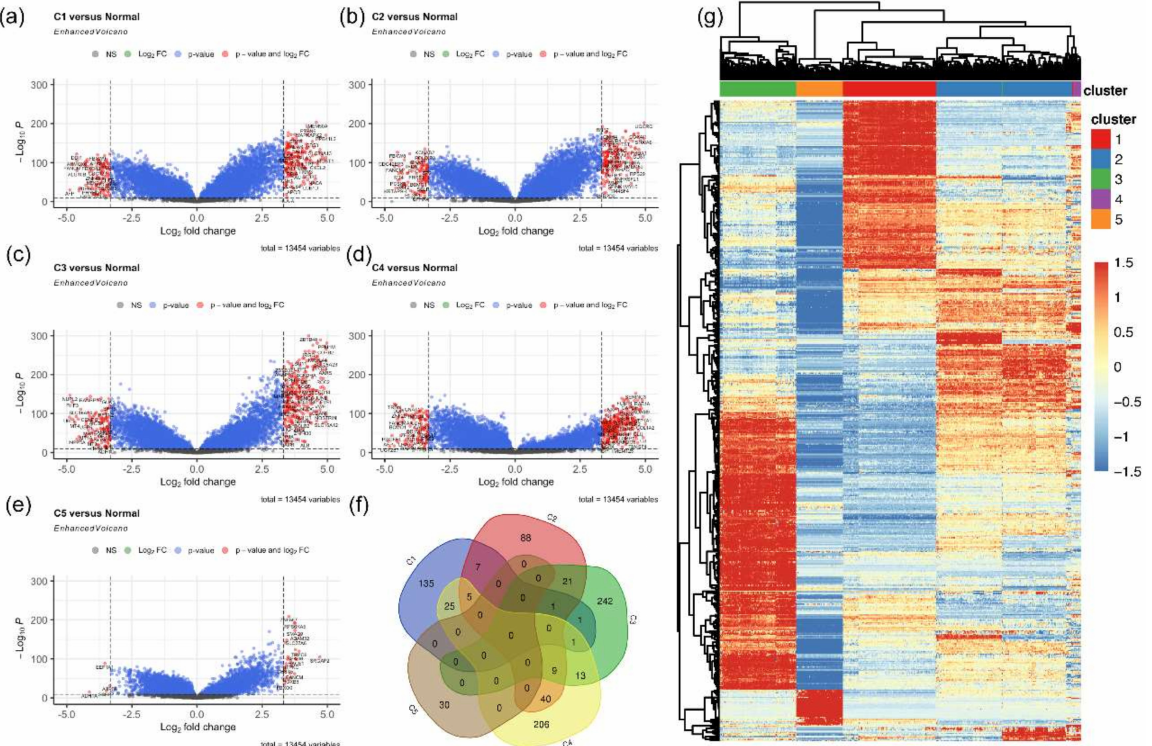
Figure 4. Differentially expressed genes (DEGs) in each cluster compared to normal tissues. Volcano plots comparing the fold change in clusters and normal tissues illustrate DEGs in ( a ) cluster 1, ( b ) cluster 2, ( c ) cluster 3, ( d ) cluster 4 and ( e ) cluster 5. Statistically significant DEGs which meet the fold change cut-off are represented by red dots (adjusted p < 0.001), blue dots represent significant DEGs beyond the log2 fold change cut-off (adjusted p < 0.001), and grey dots represent non-significant genes. ( f ) Venn diagram of upregulated DEGs that are unique in each cluster. ( g ) Heatmap of the upregulated DEGs that are unique in each